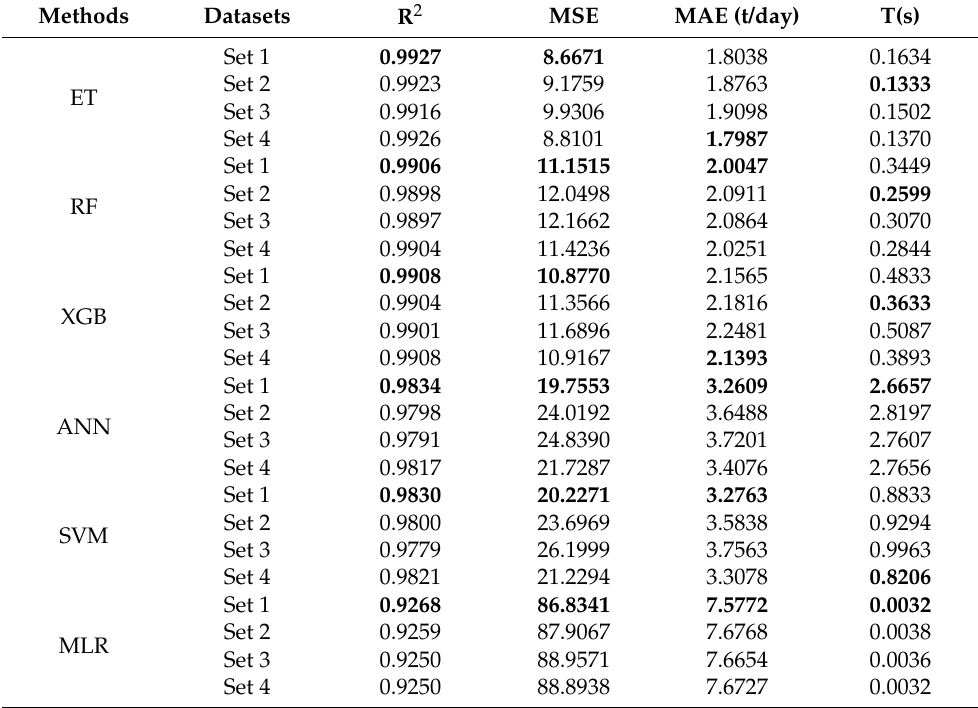
Table 4. Effects of wind, wave and current factors on the results of the reference